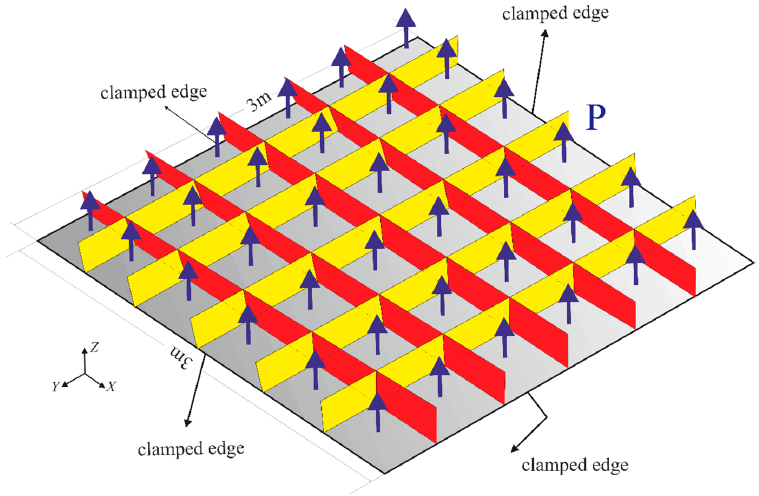
Figure 24. Clamped stiffened plate geometry under distributed load.